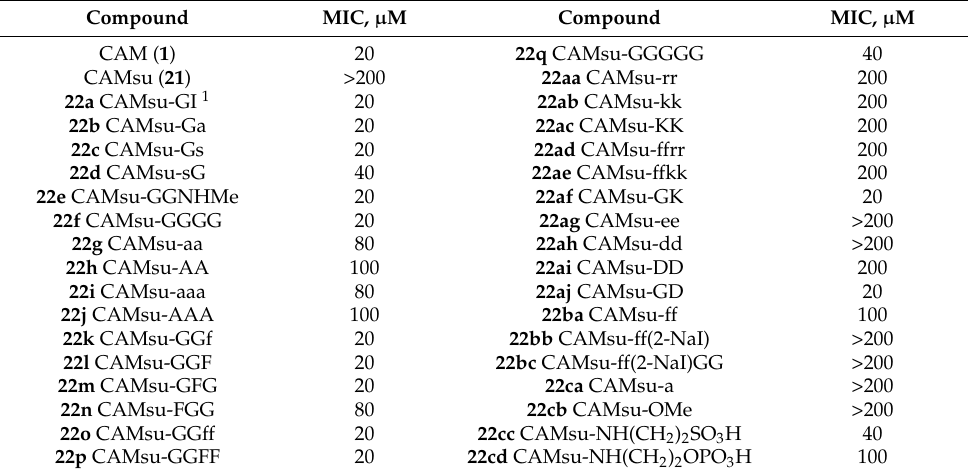
Table 2. Antibacterial activity of peptide-CAM conjugates 22 against E. coli K-12 (MIC, µM). Compound